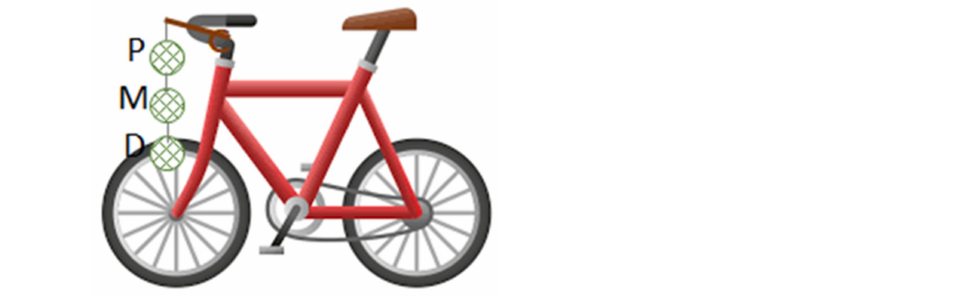
Figure 7. The arrangement of the bicycle hosting moss-bags in triplicate. Bag position: proximal—P; middle—M;